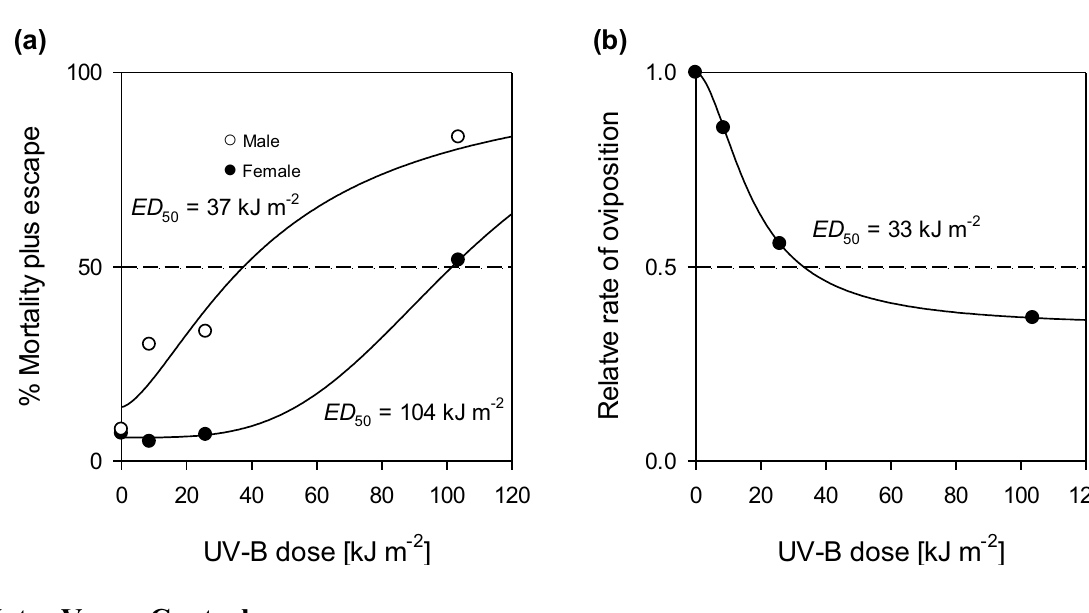
Figure 3. Effects of 3-day UV-B irradiation (4 h d (cid:237) 1 ) on (a) mortality plus escape rate and (b) oviposition by adult two-spotted spider mite ( Tetranychus urticae ). Oviposition rates are shown relative to the 3-d rate (18.9 ± 0.4 eggs per female) under continuous